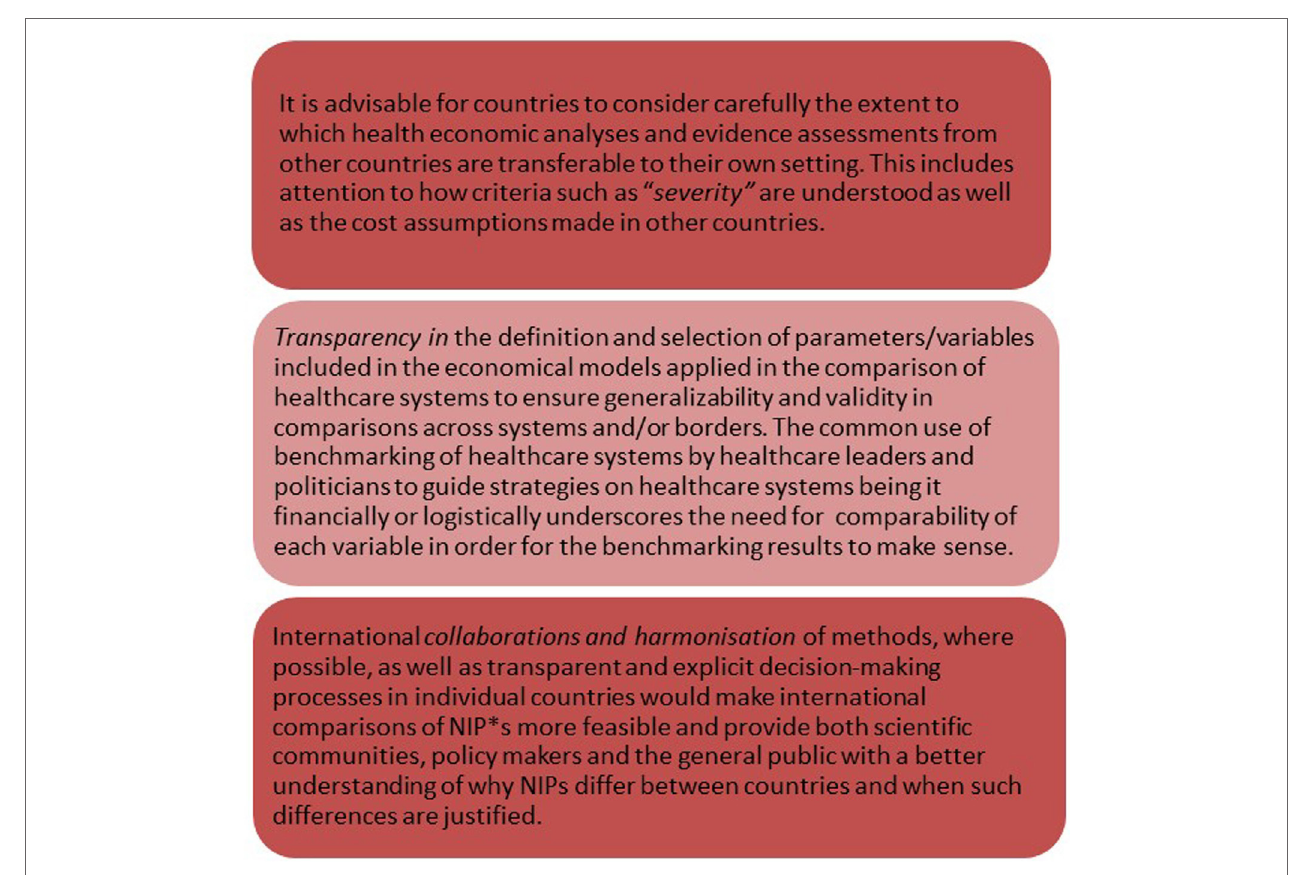
fiGUre 1 | Actionable recommendations. Abbreviation: NIP, national immunization